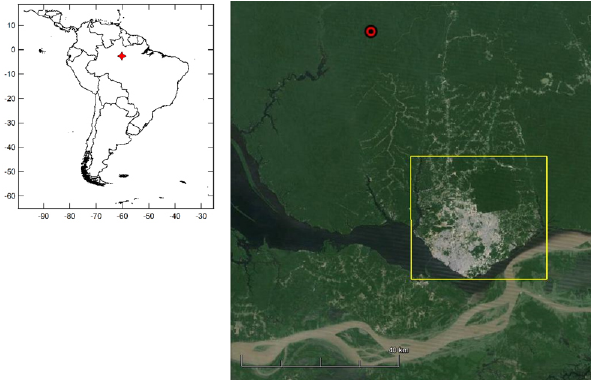
Figure 1. Location of the sampling site, shown by the red markers. The yellow rectangle represents the bounding box around Manaus used to flag air masses influenced by pollution from the